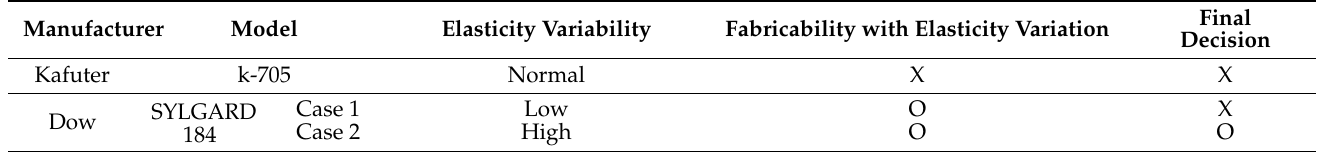
Table 1. Compare to materials to manufacture